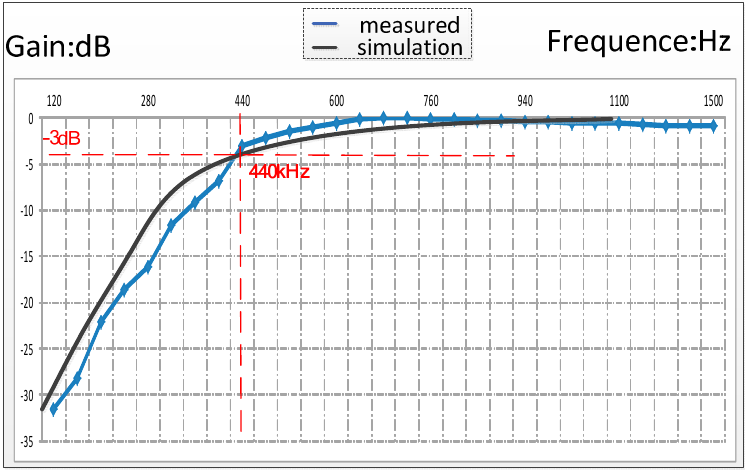
Figure 4. The waveform of simulation and experiment results about the HPF frequency characteristics.